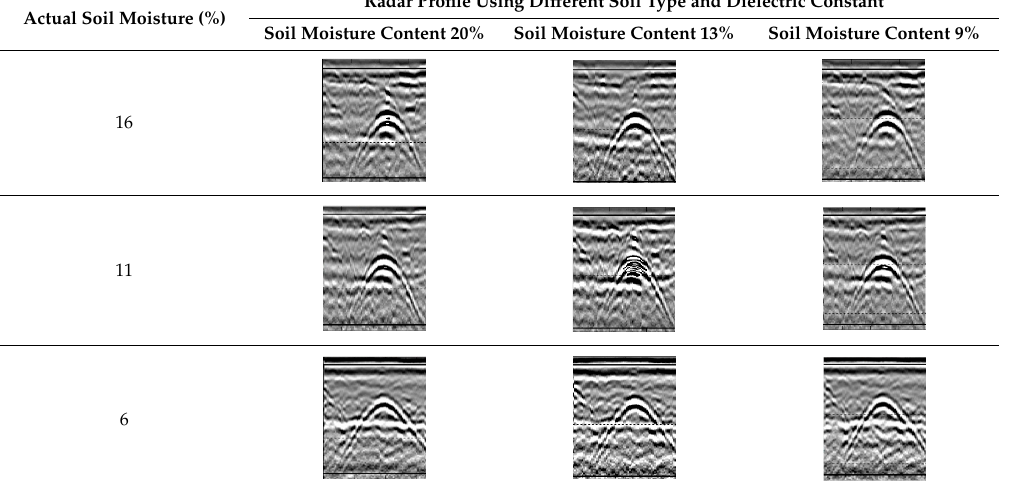
Table 6. Radar profiles of root proxies at different soil moisture levels. GPR settings were adjusted on the basis of soil type and dielectric constant.